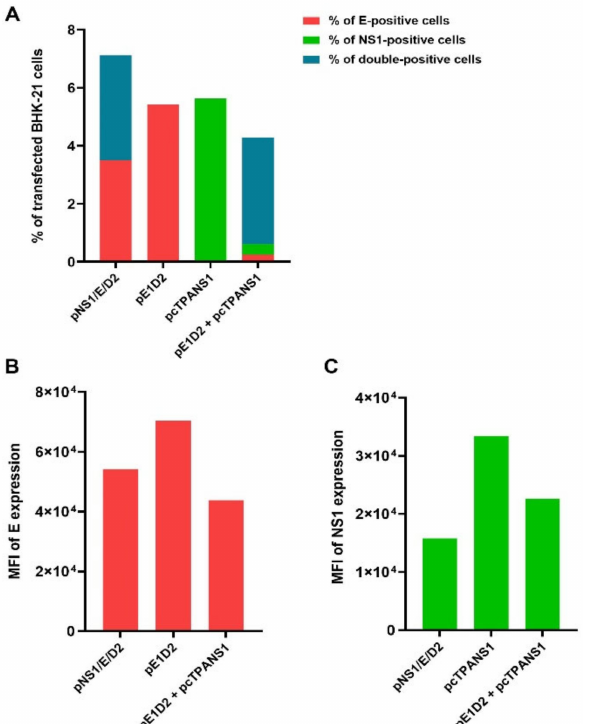
Figure 3. Quantification of in vitro expression of the E and NS1 proteins in cells transfected with the different DNA vaccines. Flow cytometry analysis showing E- and NS1-positive frequencies in BHK-21 cells transfected with the control pcTPA or with the DNA vaccines pNS1/E/D2, pE1D2, pcTPANS1, and pE1D2 + pcTPANS1 ( A ), and the mean of fluorescence intensity (MFI) for E ( B ) and NS1 staining ( C ). Transient transfection was carried out with lipofectamine reagent. After the 24h-transfection, cells were harvested and stained with mouse monoclonal anti-E (3H5) antibody and rabbit polyclonal anti-NS1 antibodies, followed by incubation with goat anti-mouse IgG conjugated to Alexa Fluor 546 and goat anti-rabbit IgG conjugated to Alexa Fluor